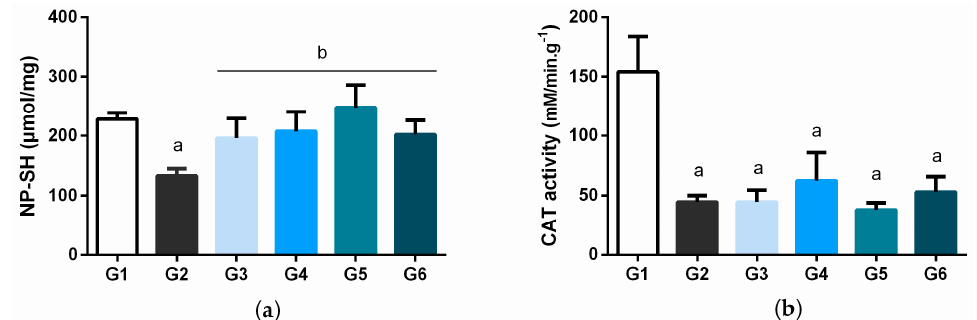
Figure 6. Hepatic concentrations of non-protein sulfhydryl groups (NP-SH) ( a ) and liver catalase (CAT) activity ( b ) in STZ-induced diabetic rats at the end of 4 weeks of treatment with bacuri seed butter (BSB). Legend: normal control (G1); diabetic control (STZ) (G2); STZ + BSB 25 mg/kg (G3); STZ + BSB 50 mg/kg (G4); STZ + BSB 100 mg/kg (G5); STZ + insulin NPH 6 UI/day (G6). a p < 0.05 vs. normal control; b p < 0.05 diabetic control; one-way ANOVA and Tukey’s post hoc test. 3.6. Morphological Changes in Liver Tissue of Diabetic Animals Treated with Bacuri Seed Butter (BSB) (Platonia insignis Mart. )